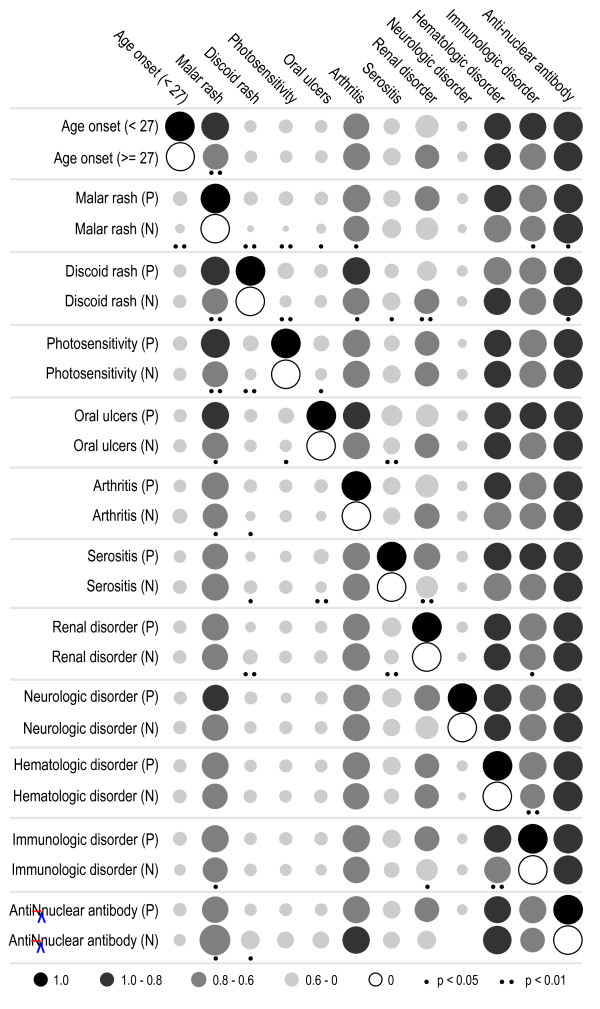
Comparison of the composition of each patient group with or without a certain subphenotype. P, patient group with a certain subphenotype; N, patient group without the subphenotype. The area of each cycle is proportional to the conditional frequency, which is the proportion of each subphenotype (upper side of figure) in a P or N group.